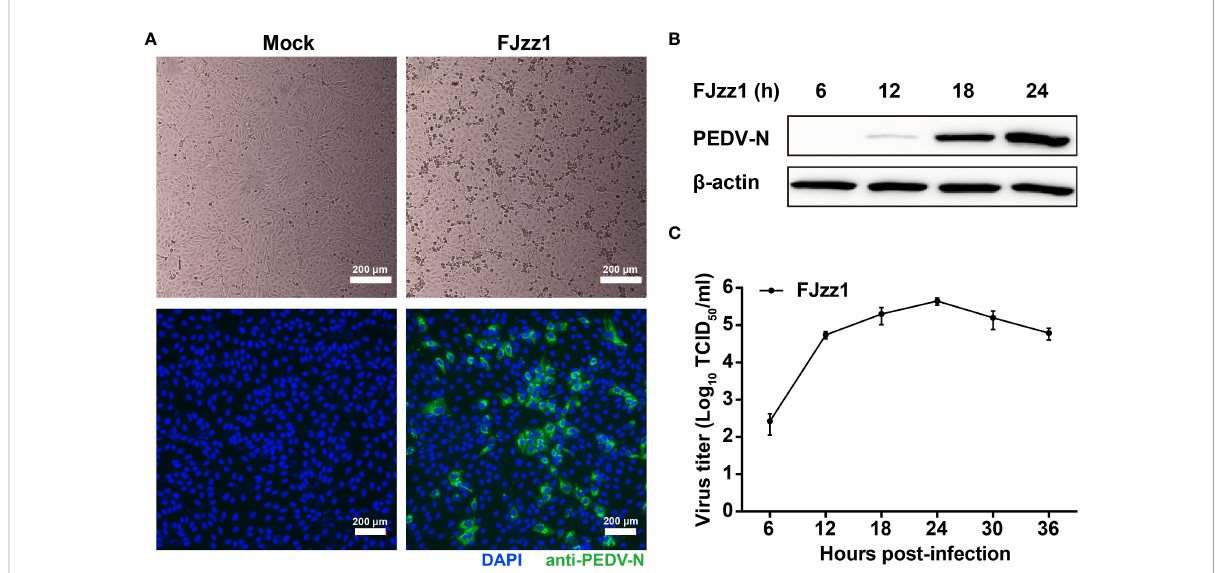
FIGURE 1 Ef fi cient replication of FJzz1 in LLC-PK1 cells. (A) CPE and immuno fl uorescence identi fi cation of PEDV replication in LLC-PK1 cells. LLC-PK1 cells were infected with FJzz1 at an MOI of 0.01, and a CPE was observed at 18 hpi. Then cells were fi xed with 4% paraformaldehyde and stained with mouse anti-N MAb. Scale bar = 200 m m. (B) Expression of the N protein in FJzz1-infected LLC-PK1 cells was detected by Western blotting. LLC-PK1 cells were infected with PEDV at an MOI of 0.01, and Western blotting was conducted using anti-N MAb at 6, 12, 18, and 24 hpi, respectively. (C) Multi-step growth kinetics of FJzz1 in LLC-PK1 cells. LLC-PK1 cells were infected with FJzz1 at an MOI of 0.01. The cell lysates were collected at the designated times and titrated with a TCID 50 infectivity